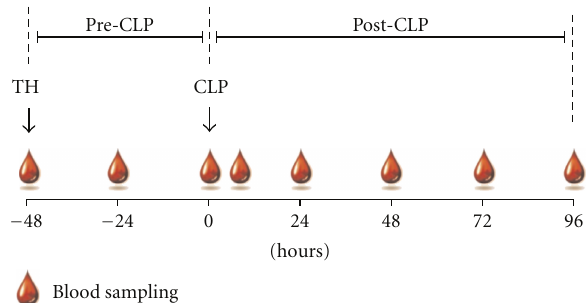
Figure 1: Schematic of the two-hit model and repetitive blood sampling. 3-month-old female mice were subjected to trauma and hemorrhage (TH) followed by polymicrobial CLP-induced sepsis. Time span of model was divided into a pre-and post-CLP phase. Starting at TH, a 20 µ L blood sample was collected daily (until post- TH day 7 post-CLP/day 5) from each animal, including one extra sample at 6h